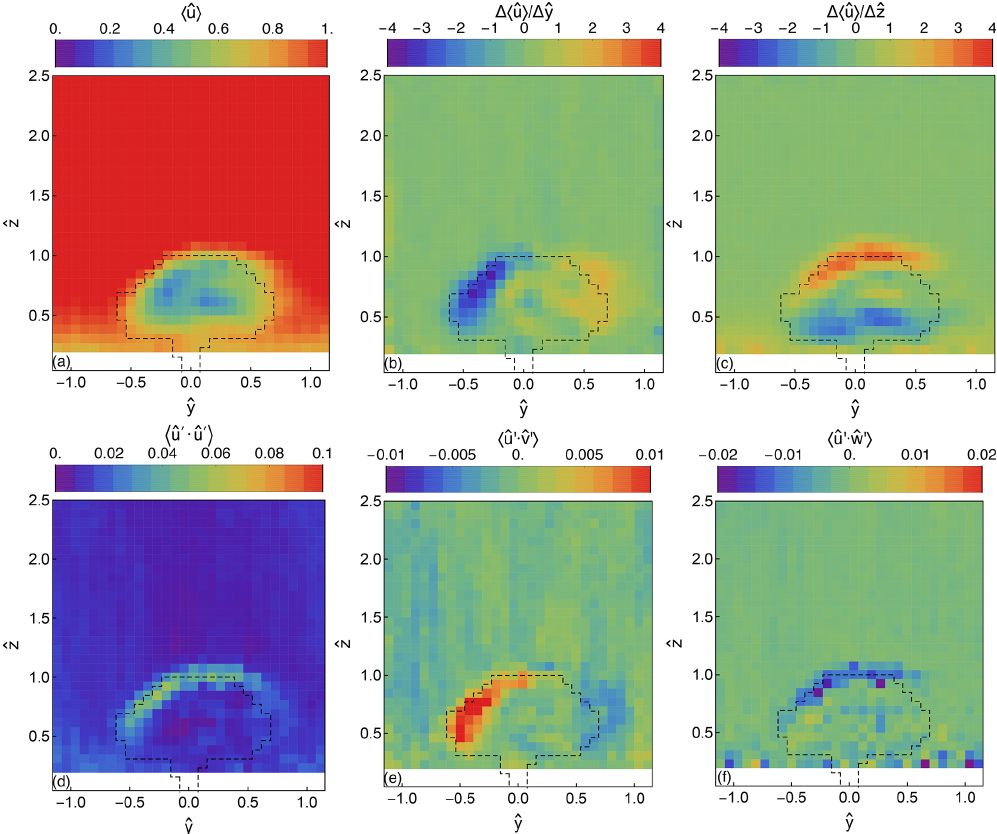
Figure 4. Normalized first and second moments of the wind on the lee side of the tree. (a) Mean streamwise component (cid:104)ˆ u (cid:105) , (b) spanwise (cid:49) (cid:104)ˆ u (cid:105) /(cid:49) ˆ y and (c) vertical (cid:49) (cid:104)ˆ u (cid:105) /(cid:49) ˆ z gradient of the mean streamwise component, (d) streamwise variance (cid:104)ˆ u (cid:48) ˆ u (cid:48) (cid:105) , (e) horizontal (cid:104)ˆ u (cid:48) ˆ v (cid:48) (cid:105) , and (f) vertical (cid:104)ˆ u (cid:48) ˆ w (cid:48) (cid:105) covariances of the longitudinal wind component. The dashed line in all figures represents the periphery of the